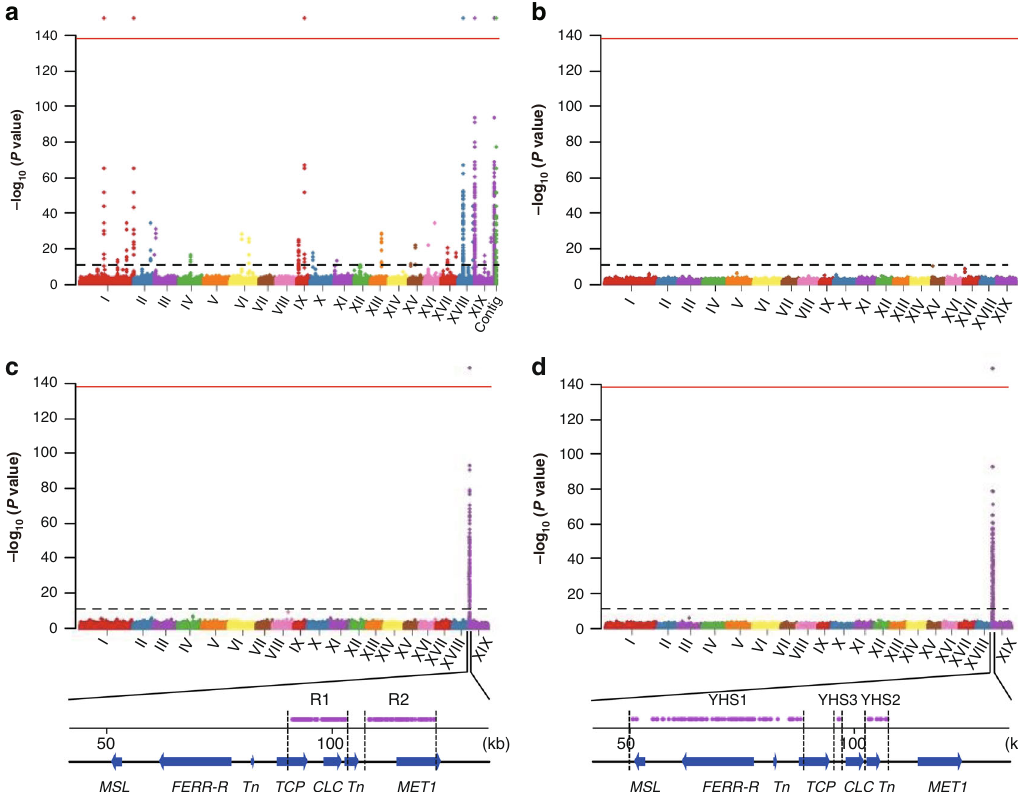
Fig. 2 Manhattan plots of GWAS analysis of P. deltoides sex phenotypes. The y -axis shows the negative logarithm of P values from Wald Chi-Squared Test implemented in GEMMA. The black dashed line above the x -axis indicate the cut-off P value = 1e-9 (corresponding Bonferroni signi fi cance = 0.01). The red line at the top of each diagram indicate cut-off P value = 1e-137 (corresponding to Bonferroni signi fi cance = 1e-130). The Roman numerals under the x -axis indicate the chromosome identity. a shows results of SNPs GWAS using the female genome as the reference ( ‘ Contig ’ on the x -axis represents the unplaced Contig01665). b shows results of coverage GWAS using the female genome as the reference. c shows results of SNPs GWAS using SLR-Y as reference. d shows results of coverage GWAS using SLR-Y as reference. R1, R2, YHS1-YHS3 at the bottom of c and d indicate regions contain GWAS signals completely associated with sexes. Note that the FERR-R and MSL genes are not shown as signi fi cant in c , because the SNP analysis is not relevant to these genes, since they are absent from the X